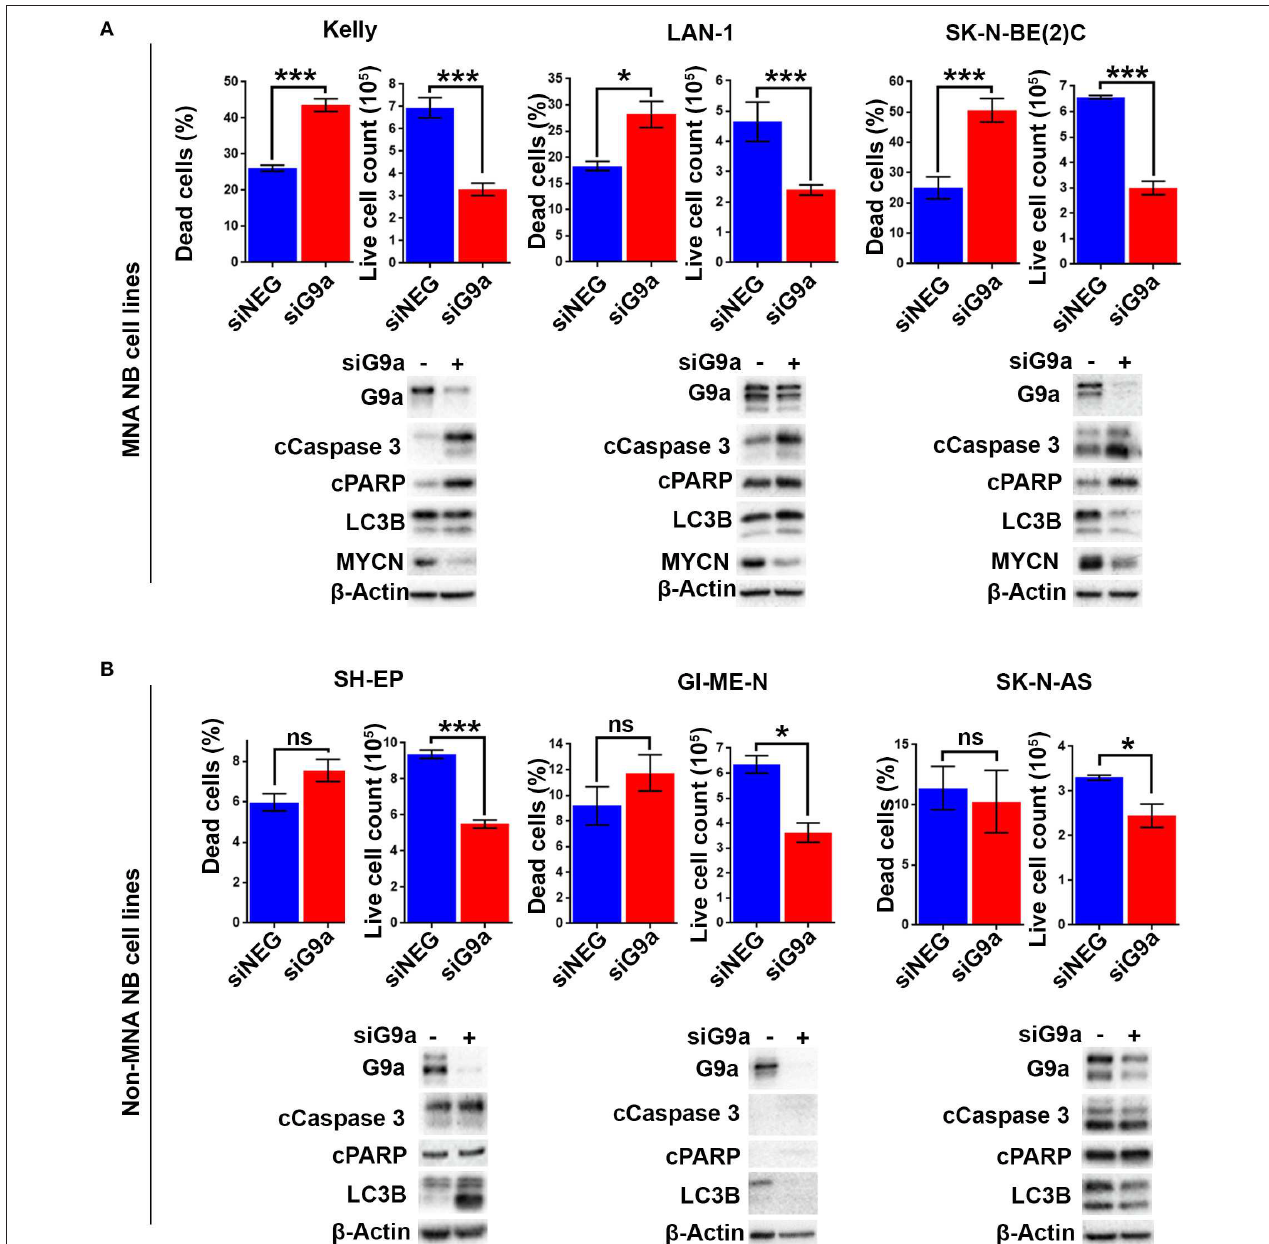
FIGURE 3 | Apoptotic cell death following G9a depletion is dependent on MYCN. (A) Floating and adherent cells from MNA cell lines were harvested and counted by trypan blue inclusion assay following G9a depletion. The left-hand graph of each cell line shows the percentage dead cells between the G9a depleted and negative control. The right-hand graph shows the live cell count of the cells harvested, which is used as a proxy for cell growth. Significant changes are measured the asterisks (* p < 0.05, *** p < 0.01, ns, not significant, n = 3). Error bars show the SEM. For each cell line, an immunoblot showing effective depletions, apoptosis and autophagy markers is shown below. β -Actin is used as loading control. The blots are representative of n = 3. (B) Live and dead cell counts and Western blots in non-MNA cell lines.